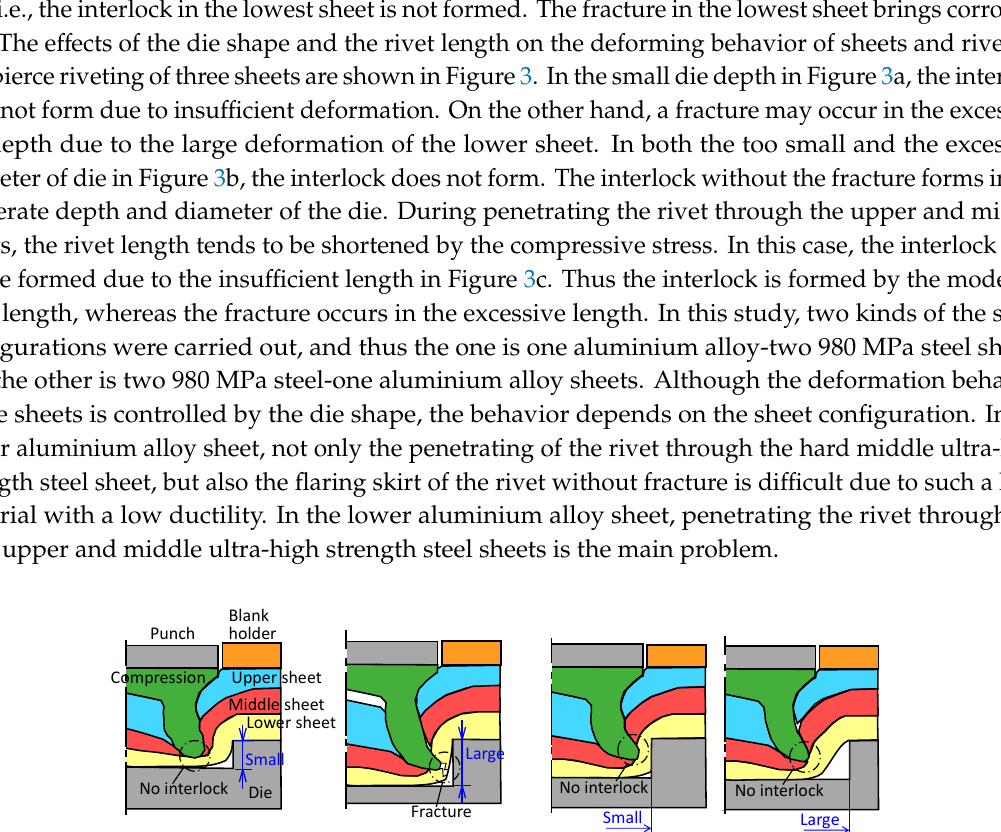
Figure 3. Effects of die shape and rivet length on the deforming behavior of sheets and rivets in the self-pierce riveting of three sheets: ( a ) die depth H ; ( b ) die diameter D ; ( c ) rivet length L .